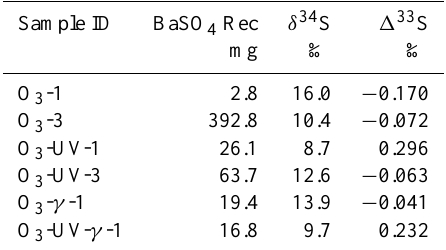
Table 1. Samples and results. The table displays a sample ID, the mass of BaSO 4 recovered, and the isotopic fractionation data (nor- malized against the references as defined in Appendix B). The sam- ple ID refers to the method of sulphate production: O 3 is the liquid phase oxidation by ozone, UV is when the UV lamps were turned on, and γ is when the gamma source was used. The number at the end of the ID refers to the position of the bottle in the sampling line (see Fig.